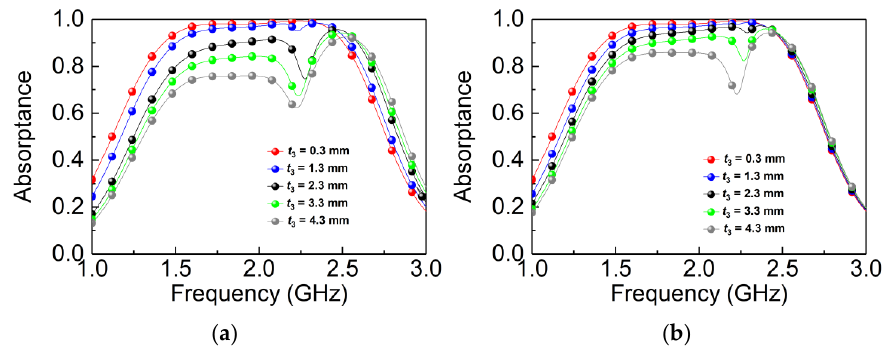
Figure 8. Simulated absorptance with different values of t 3 : ( a ) TE wave; ( b ) TM wave.